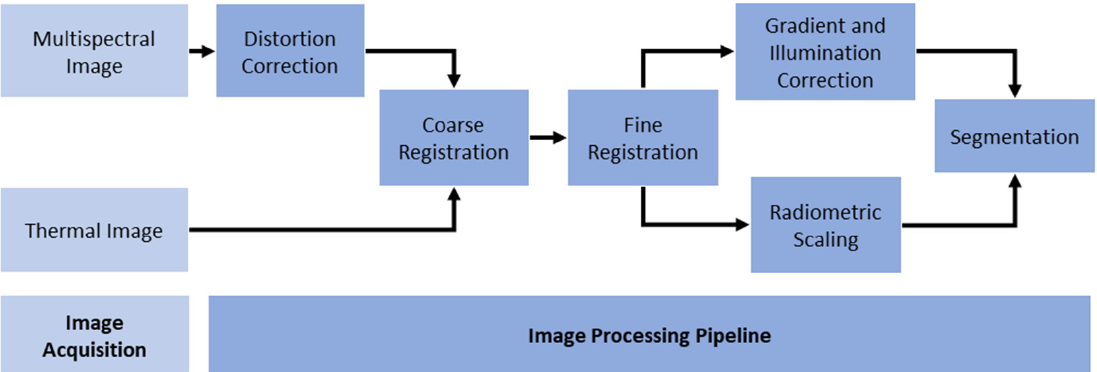
Figure 2. The image processing pipeline. The steps include image acquisition by thermal and multispectral cameras, and image processing for distortion correction of multispectral images, image registration (coarse and fine), radiometric scaling of thermal images, and illumination correction of multispectral images.